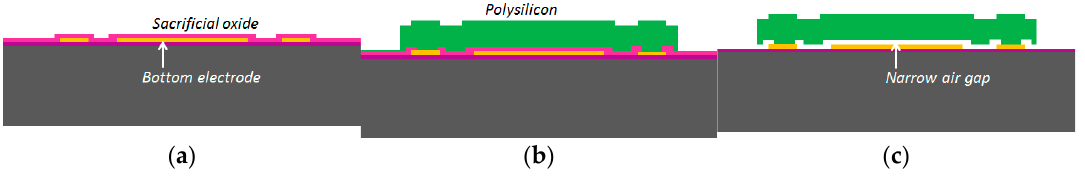
Figure 18. Fabrication of vertical narrow gaps in a polysilicon-based process: ( a ) Growth of sacrificial oxide; ( b ) Growth and patterning of polysilicon structural layer after patterning of sacrificial oxide; ( c ) Release of polysilicon structure of removal of sacrificial oxide.